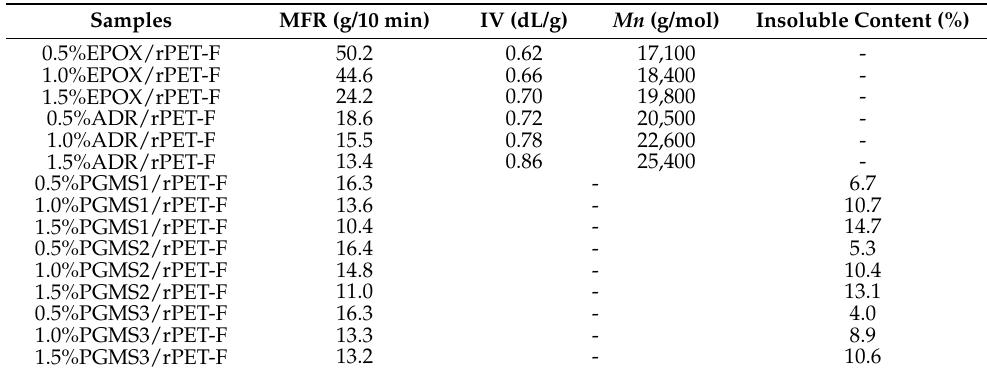
Table 3. The IV and the MFR of chain extended rPET-F